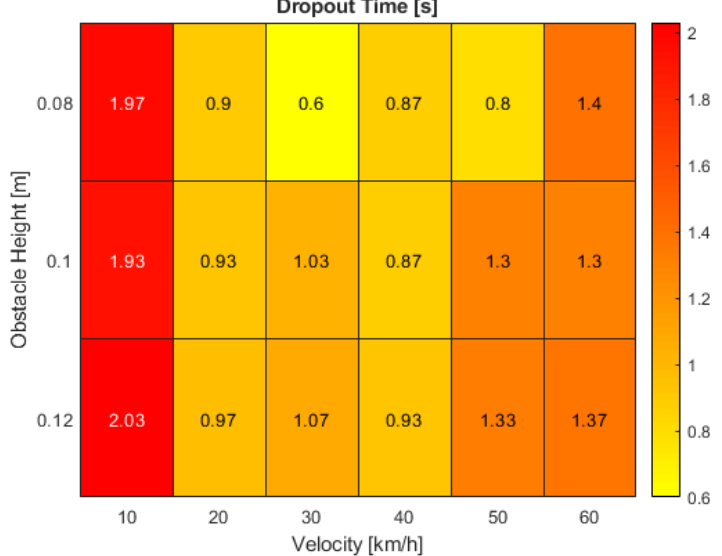
Figure 8. Distance estimation dropout time at various bump obstacle heights and vehicle velocities in the